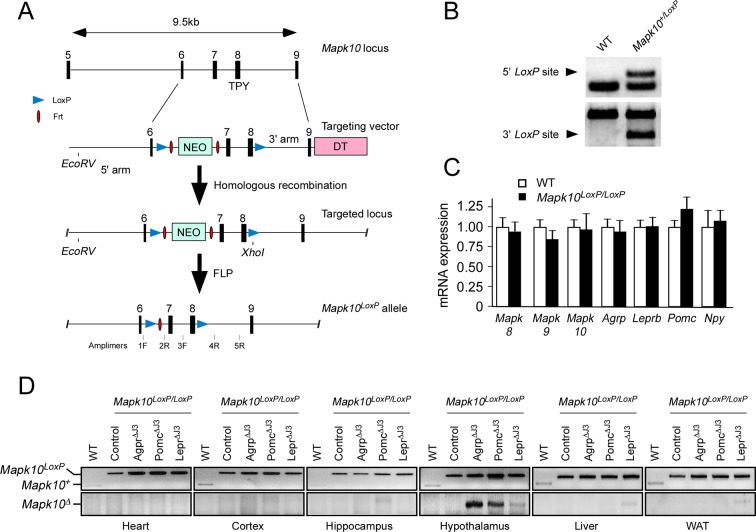
Establishment of Mapk10LoxP/LoxPmice.(A) The strategy employed to target the Mapk10 locus (exons 6–9) by homologous recombination is illustrated. Restriction sites and PCR amplimers are indicated. Abbreviations: NEO, neomycin resistance cassette; and DT, diptheria toxin cassette. (B) The integrity of 5’ and 3’ LoxP sites of the Mapk10LoxP allele were verified by PCR analysis of genomic DNA using amplimers 1F & 2R (5’ site) and 3F & 5R (3’ site). (C) Comparison of hypothalamic expression of selected genes in WT and Mapk10LoxP/LoxPmice by Taqman© assays. No significant differences (p>0.05) between WT and Mapk10LoxP/LoxPmice were detected (mean ± SEM; n=3). (D) PCR genotype analysis of DNA isolated from different tissues of WT mice, Mapk10LoxP/LoxPmice, Agrp-cre Mapk10LoxP/LoxPmice (Agrp∆J3), Pomc-cre Mapk10LoxP/LoxPmice (Pomc∆J3), and LepRb-cre Mapk10LoxP/LoxPmice (LepR∆J3) using amplimers 1F & 2R (upper panel) and 1F & 4R (lower panel).